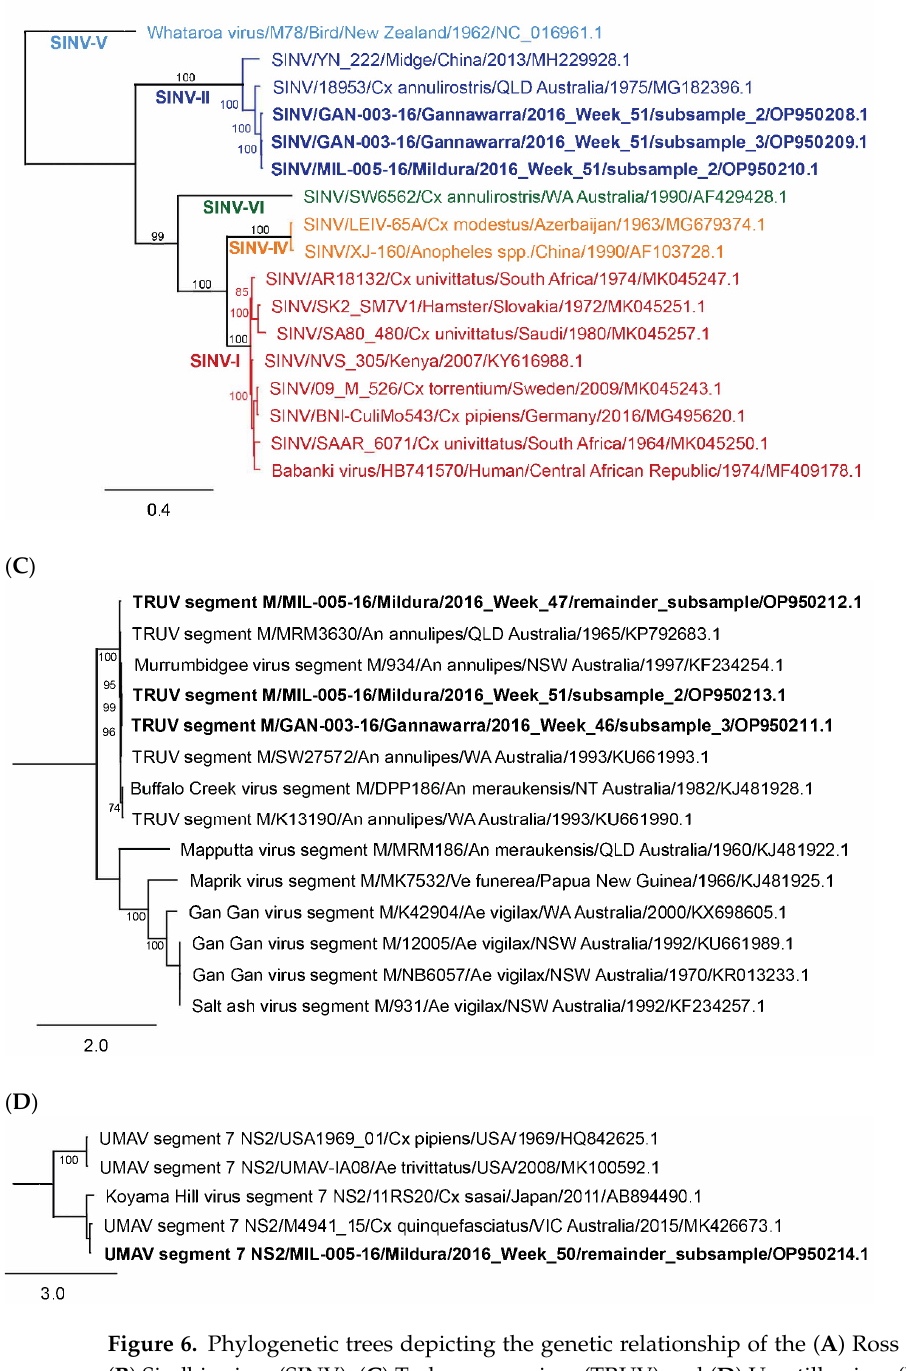
Figure 6. Phylogenetic trees depicting the genetic relationship of the ( A ) Ross River virus (RRV), ( B ) Sindbis virus (SINV), ( C ) Trubanaman virus (TRUV) and ( D ) Umatilla virus (UMAV) detections. The trees are based on whole genome sequence alignments for RRV (11,362 nt) and SINV (11,460 nt), Segment M for TRUV (4152 nt), and Segment 7 for UMAV (1364 nt). A maximum likelihood (GTR model) analysis was used with 1000 bootstrap replicates (only values > 70% were shown). Coloured clades represent virus genotypes, as indicated by the clade label. The naming convention for other viruses is virus/strain/host/location/year/GenBank accession, with boldface indicating sequences generated in this